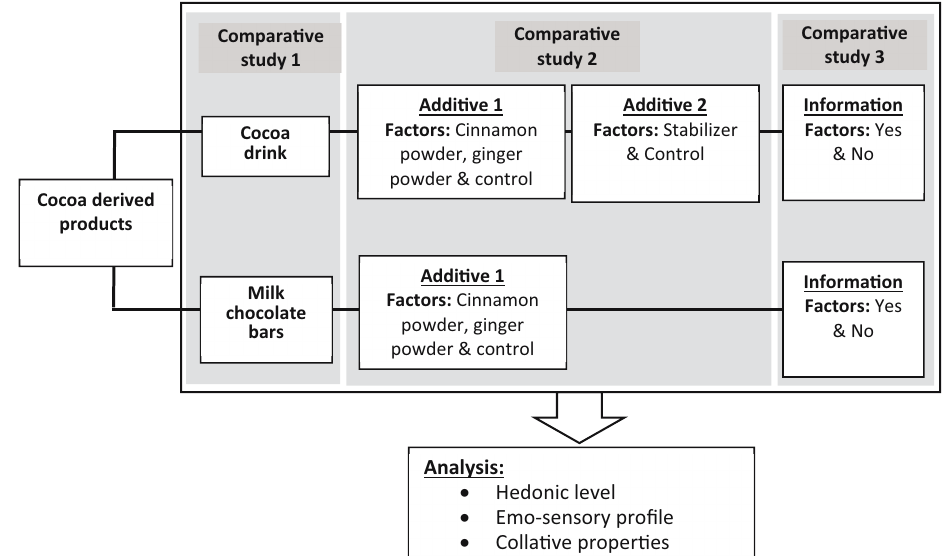
Figure 1: Schematic diagram of the research